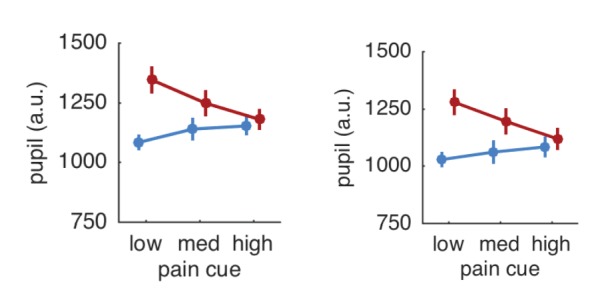
Pupil responses based on all trials (left panel) and after exclusion of trials with artifacts (right panel).